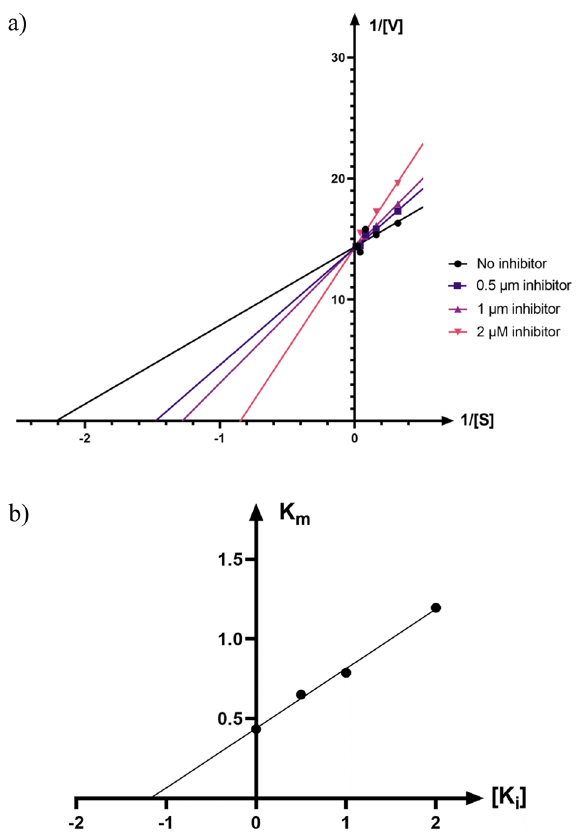
Figure 3. Kinetics of urease inhibition by 6i. ( a ) The Lineweaver–Burk plot in the absence and presence of different concentrations of 6i; ( b ) The secondary plot between K m and various concentrations of